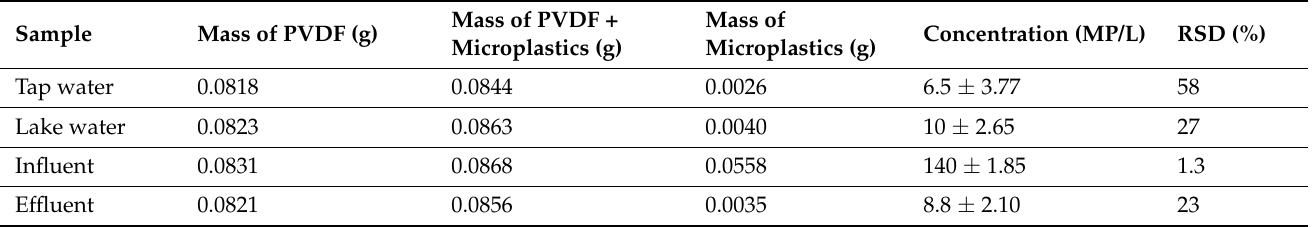
Table 2. Mass (g) and concentration (MP/L) of microplastics filtered with PVDF/ CNOs membrane from 200 mL water